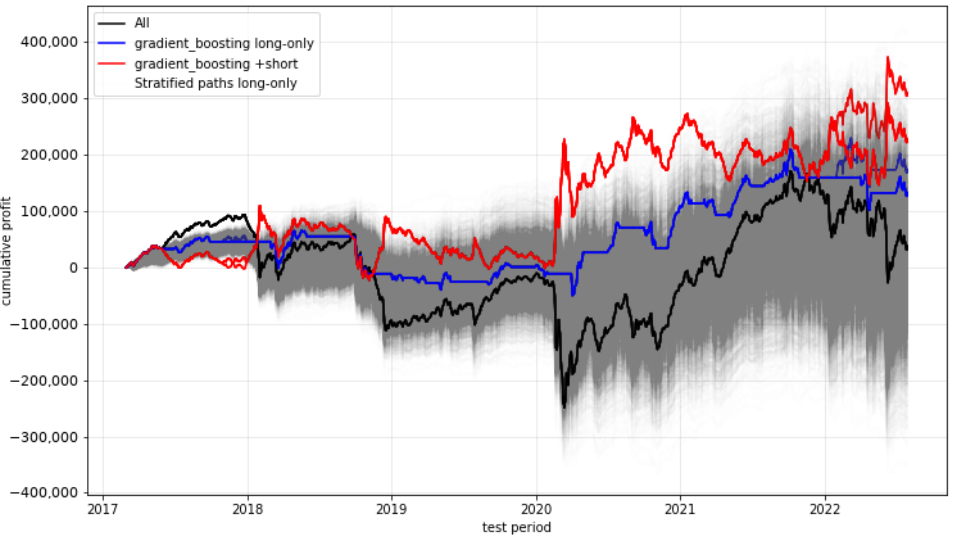
Figure 6. Cumulative profit of the gradient-boosting predictions. The black line shows the trade- always strategy (“All”), while the grey area represents a multitude of stratified paths (“Strat”). Multiple lines of the same color (i.e., blue and red) denote different model variants (or